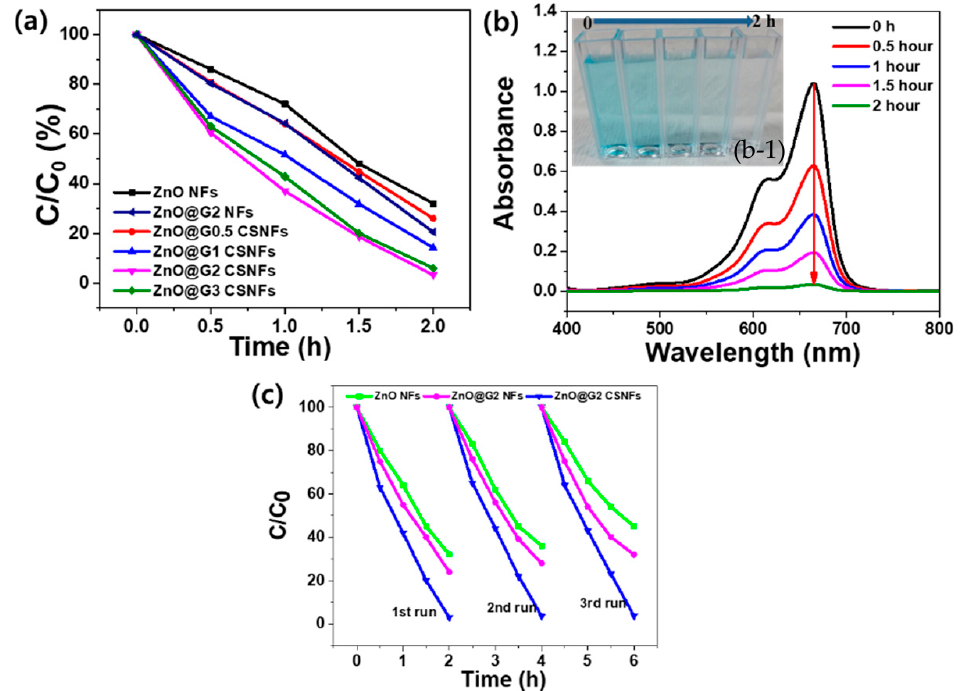
Figure 3. Photocatalytic degradation of MB by di ff erent samples under UV light ( a ); UV–vis absorbance of MB solution treated with ZnO@G2 CSNFs under UV light for 2 h ( b ), where the inset shows digital image of the samples showing color changes in a real-time ( b-1 ); and photocatalytic degradation cycles of di ff erent samples ( c ).